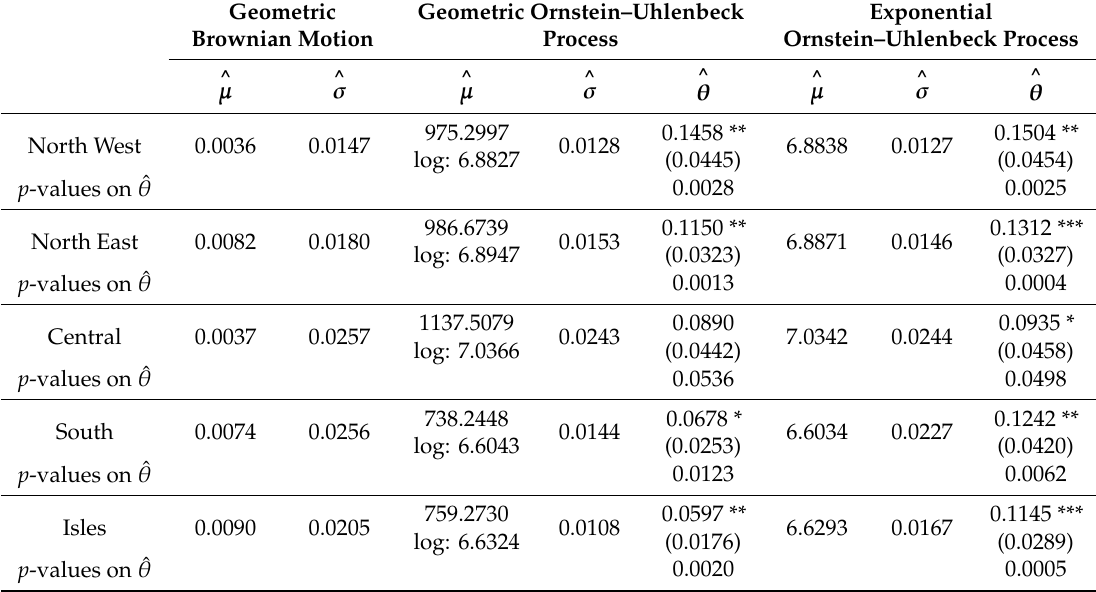
Table 1. Estimation of three di ff erent stochastic processes for the collateral value across geographic areas. Real estate data